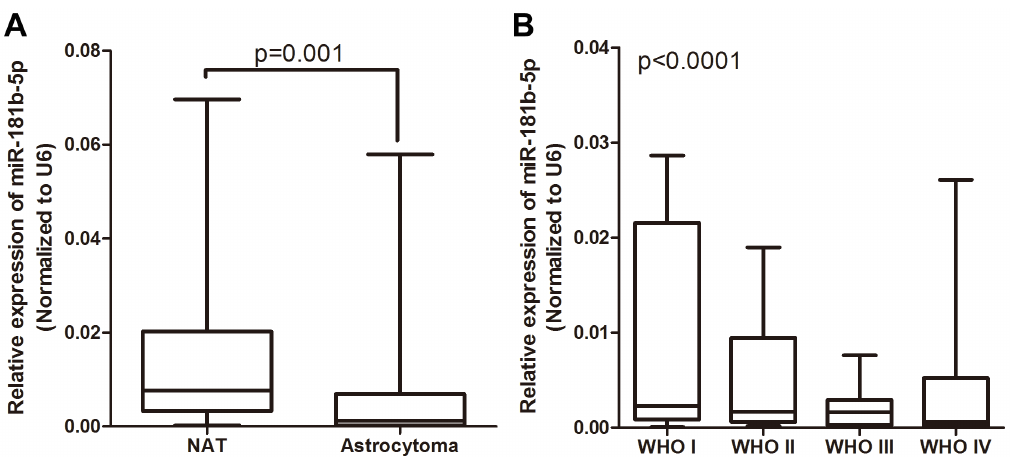
Figure 1. miR-181b-5p is downregulated in astrocytoma tissue samples. The miR-181b-5p expression was normalized to U6. (A) Relative expression of miR-181b-5p in NAT and astrocytoma tissues. (B) Relative expression of miR-181b-5p in different WHO grades of cancer